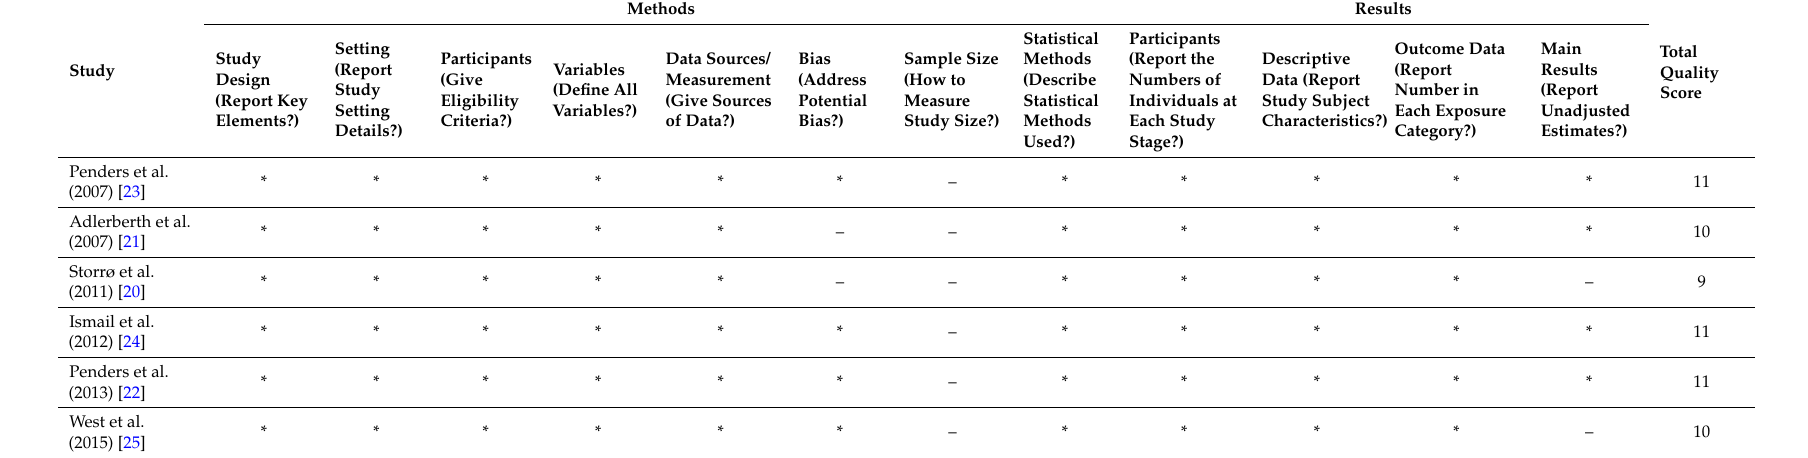
Table 2. Quality assessment of original studies. * means the study received 1 mark for that selected